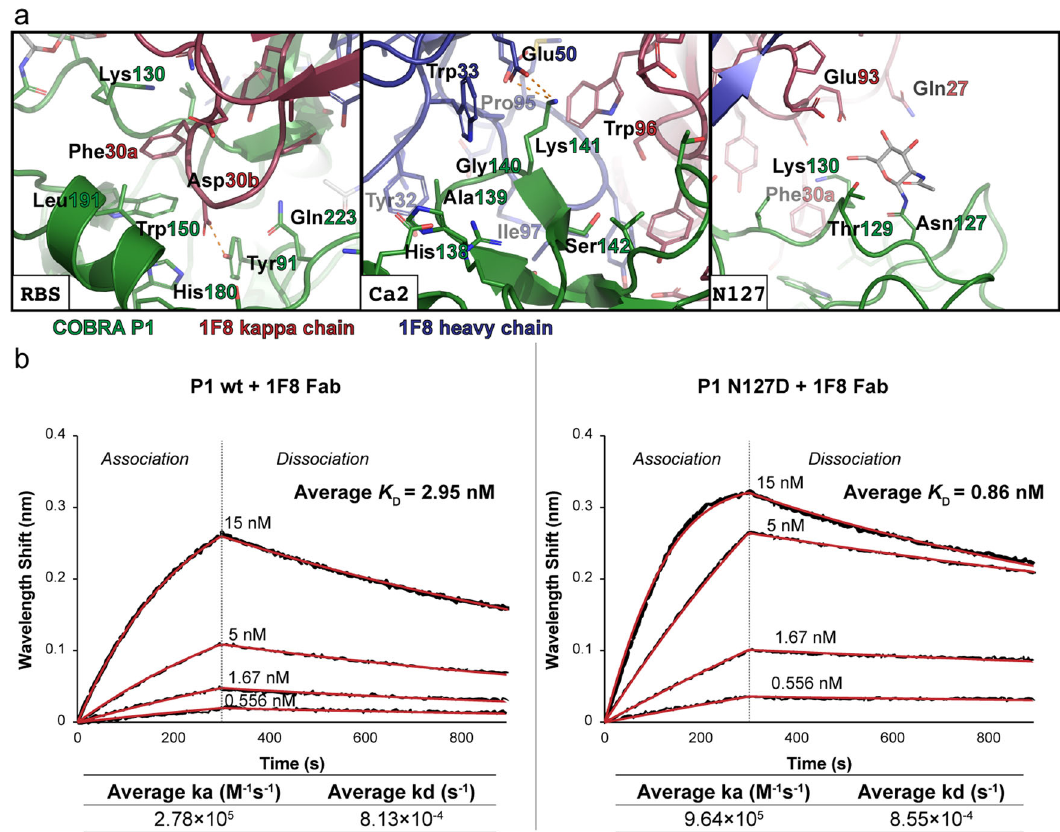
Fig. 6 Molecular interactions between COBRA P1 and Fab 1F8. a Closeup views of the interface between COBRA P1 and 1F8 in the RBS, Ca2 antigenic site, and region near the Asn127 glycan. Electrostatic interactions are shown as orange dashes. b Biolayer interferometry kinetic assays of Fab 1F8 binding with wildtype and mutant COBRA P1. Representative runs of each are shown. The K D , rate of association (ka), and rate of dissociation (kd) values are reported as the mean of two independent experiments.